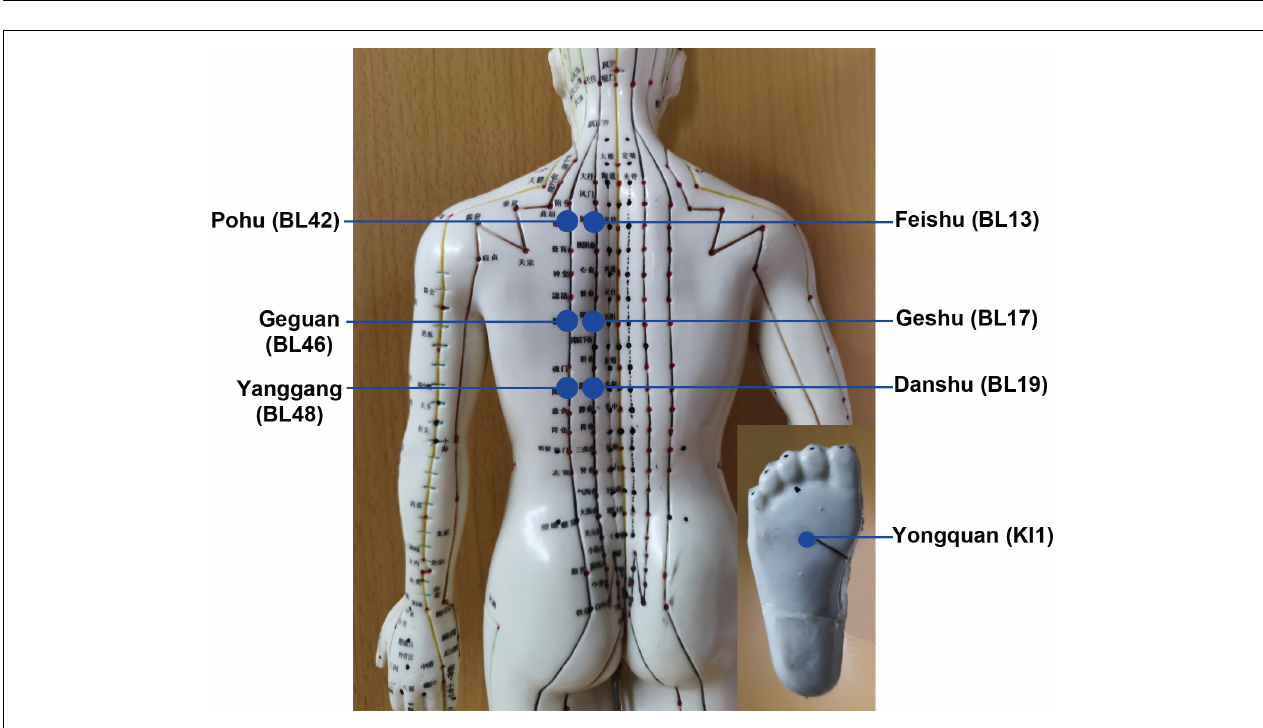
FIGURE 4 | Active vs. sham acupuncture. Shaft needles are punctured subcutaneously in active acupuncture, while blunt needles are not punctured subcutaneously in sham acupuncture.